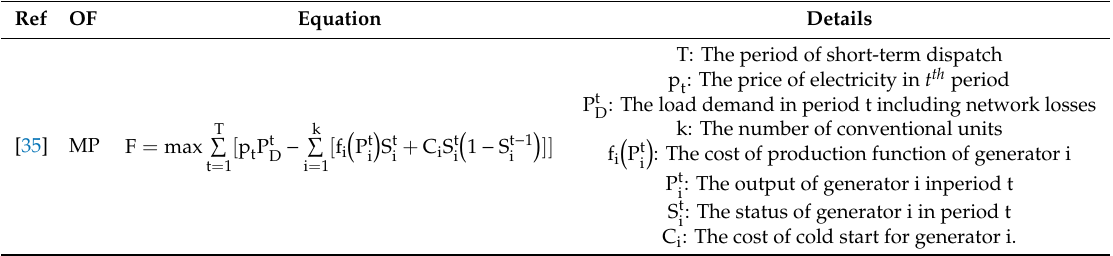
Table 1. Objective function for the studies that utilize conventional particle swarm optimization. Ref OF Equation